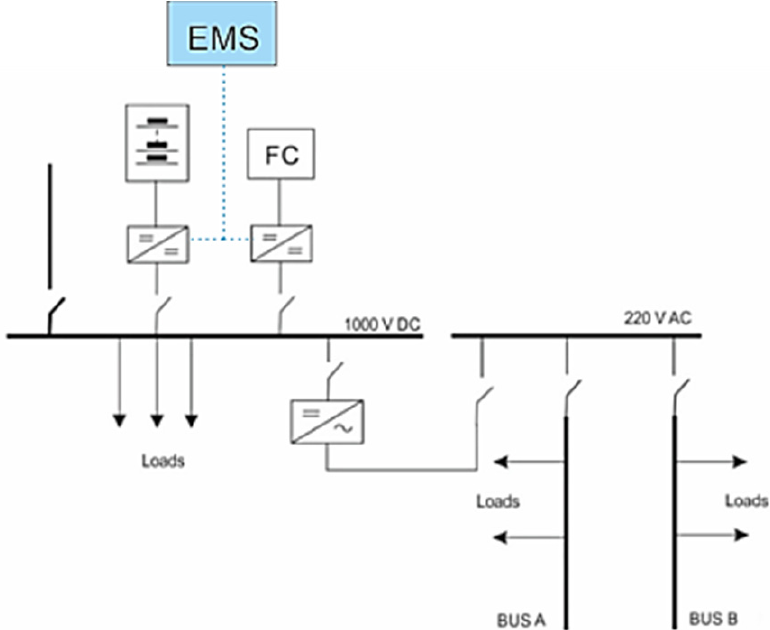
Figure 2. Modified LV distribution scheme downstream of a substation transformer supplying hotel loads.